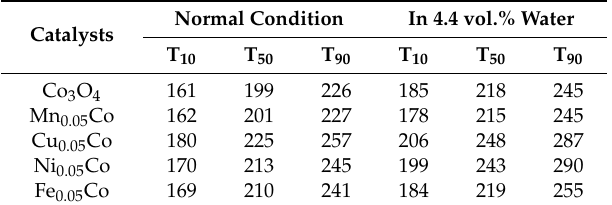
Table 5. Light-o ff temperatures at 10, 50, and 90% propane conversion upon cooling process in normal condition or in the presence of 4.4 vol.% water.